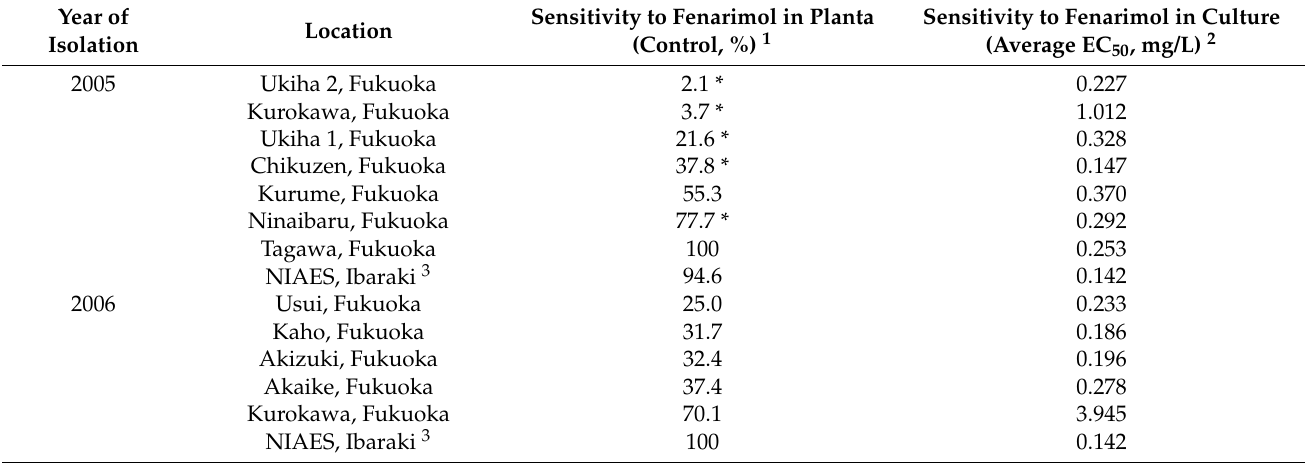
Table 1. Sensitivity of Venturia nashicola isolates to fenarimol in planta and in culture.